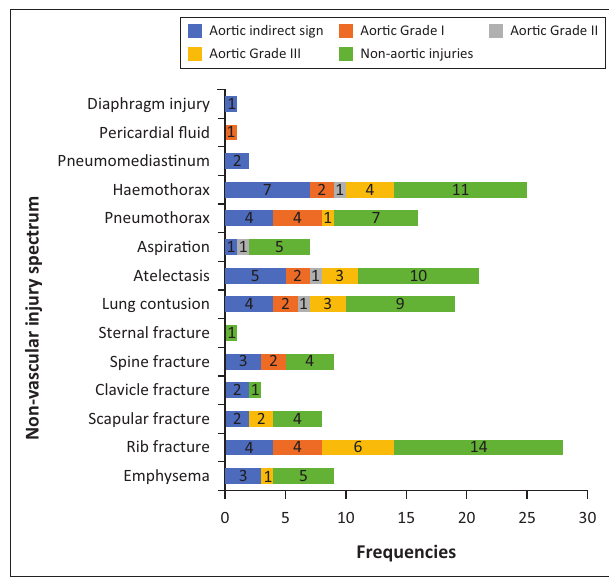
FIG URE 3: Associated non-vascular thoracic injuries in relation to the vascular injury category.